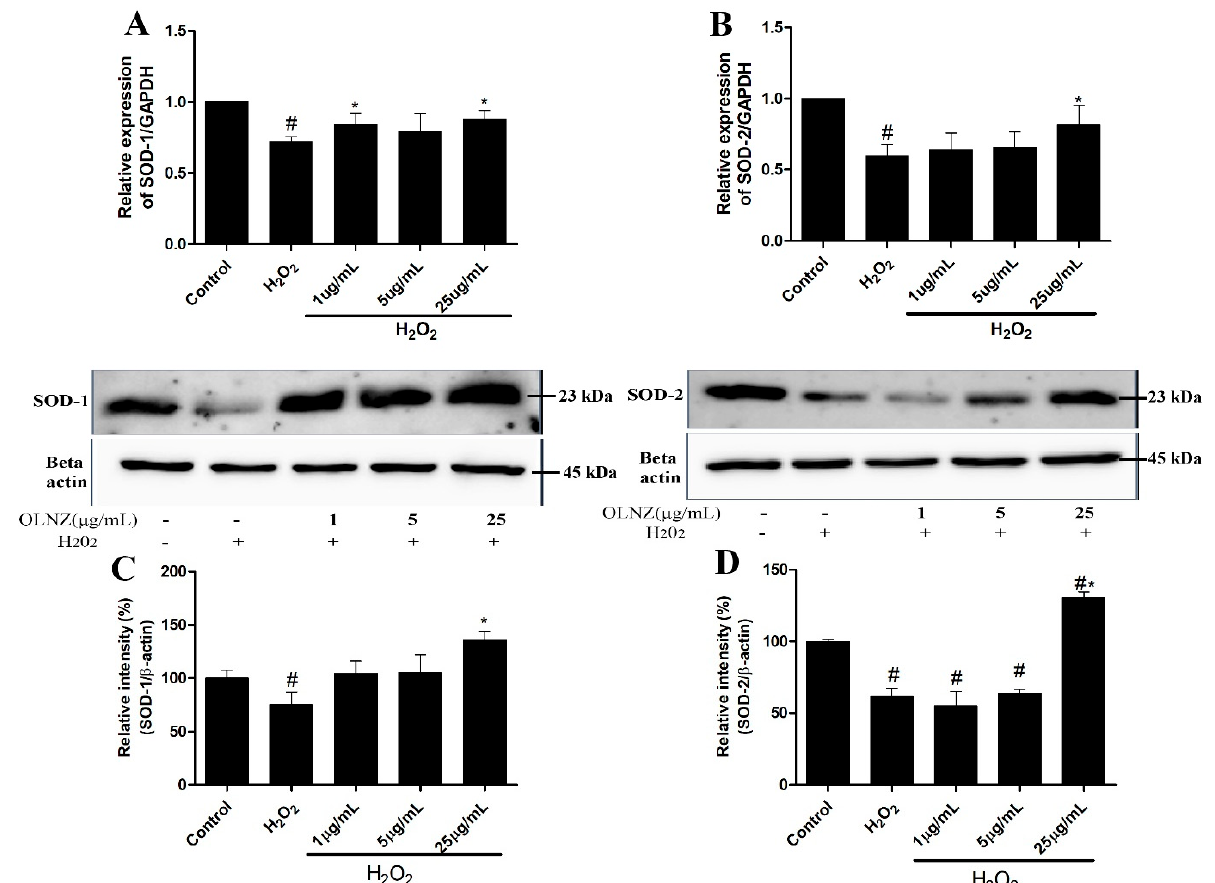
Figure 11. Effects of OLNZ on antioxidant enzyme (SOD-1, SOD-2) gene and protein expression in H 2 O 2 -induced SH-SY5Y cells. The expression of (%). ( A ) SOD-1 and ( B ) SOD-2 genes and ( C ) SOD-1 and ( D ) SOD-2 proteins was increased after pre-incubation with OLNZ in a concentration-dependent manner. Data were expressed as the mean ± SEM, and the experiment was repeated three times. (#) compared to the control and (*) compared to H 2 O 2, p < 0.05.